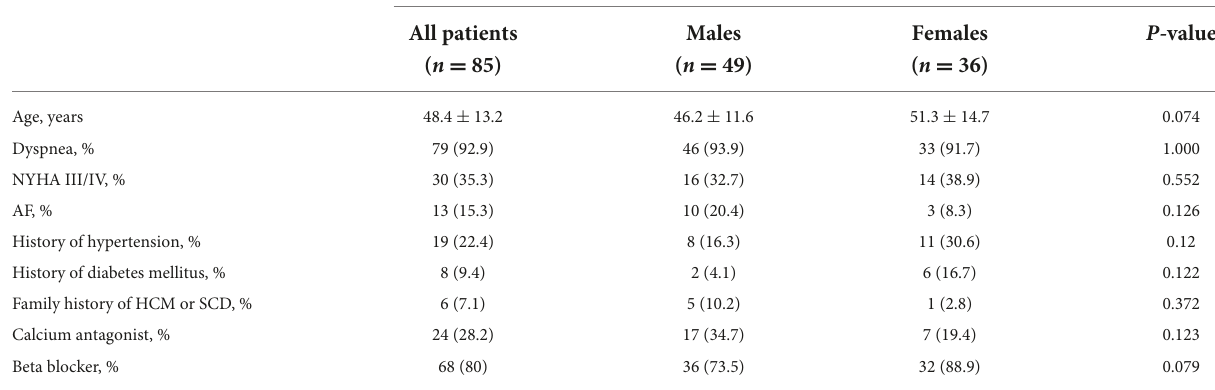
TABLE 1 Baseline clinical characteristics of patients with hypertrophic obstructive cardiomyopathy